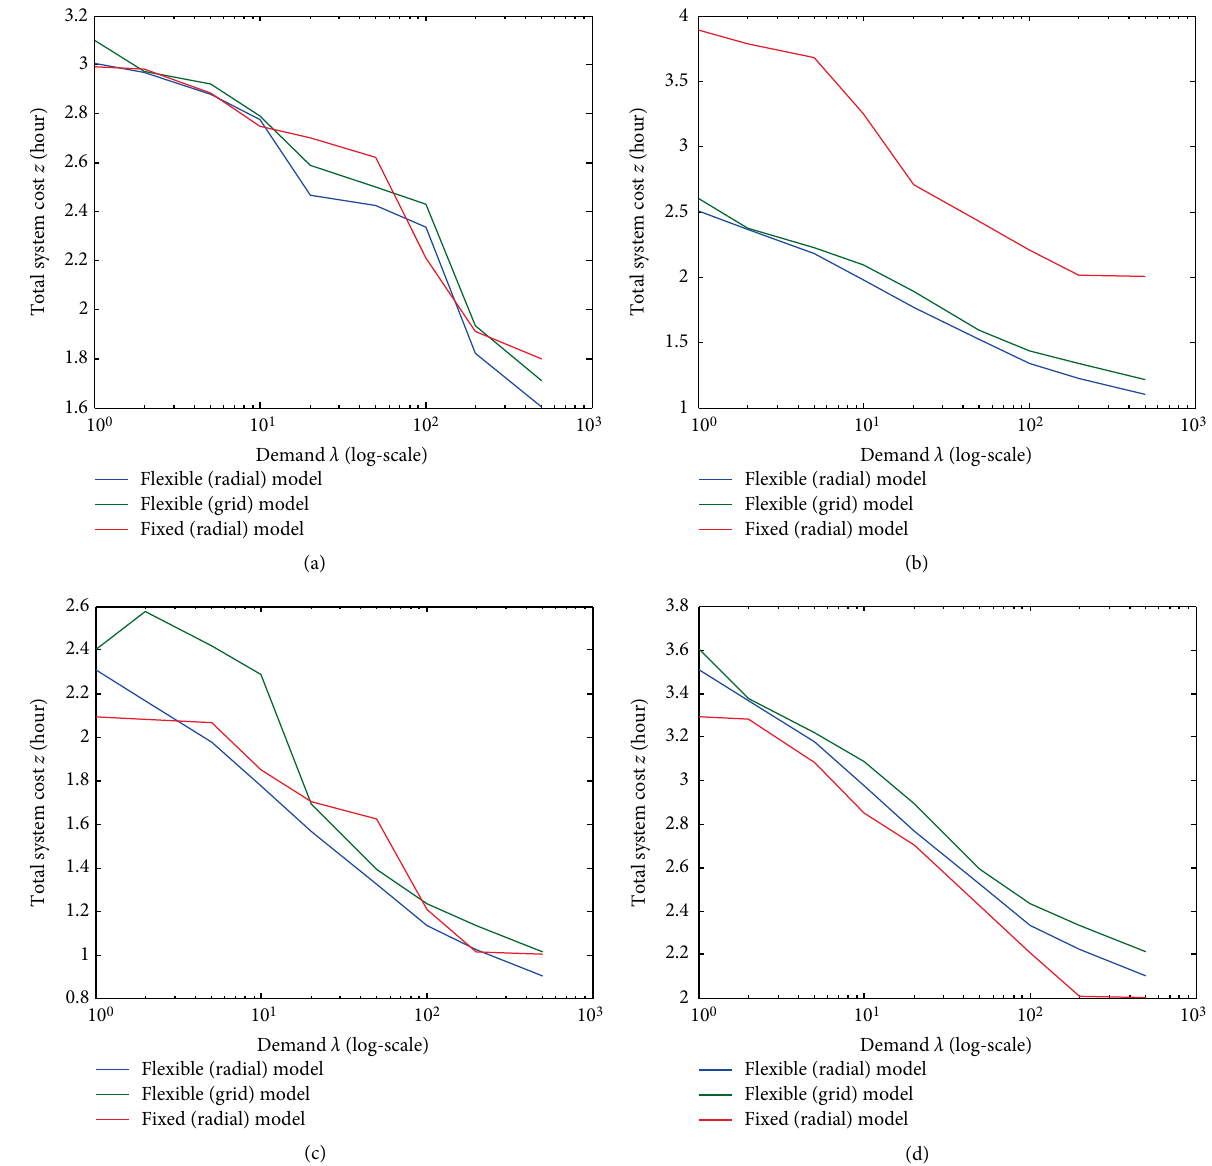
= 1 km/h. (c) v = 7.5 km/h. (d) 𝑤 𝑤